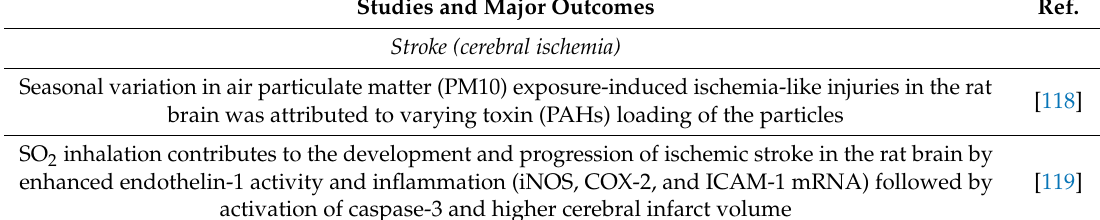
Table 1. Air Pollution E ff ects in Animal Models of Neurological and Mental Disorders. Studies and Major Outcomes Ref. Stroke (cerebral